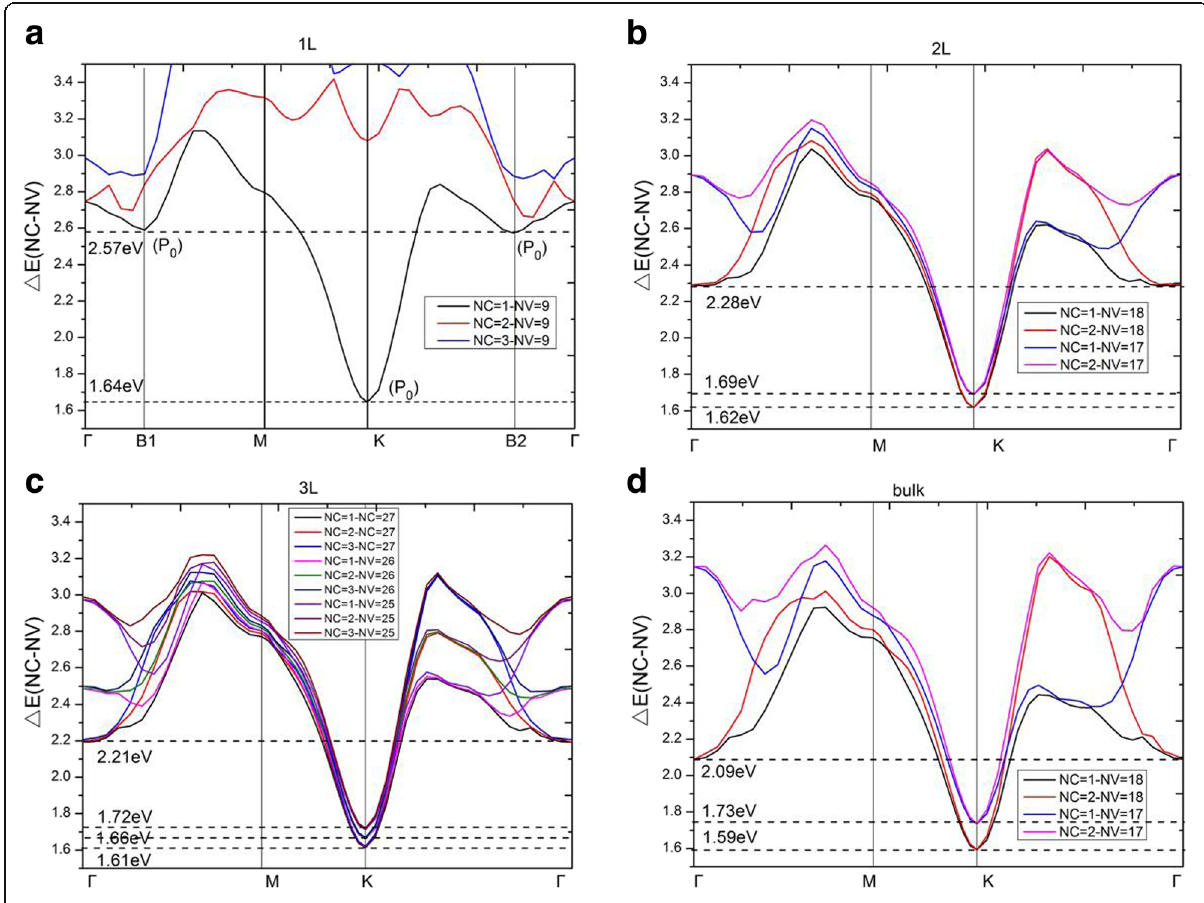
Fig. 8 Direct energy gaps, Δ E(NC − NV), between conduction and valence bands for the a monolayer, b bilayer, c trilayer, and d bulk MoS 2 . a – d There are three, six, twelve, and six critical points in interband transitions for the monolayer, bilayer, trilayer, and bulk MoS 2 , respectively